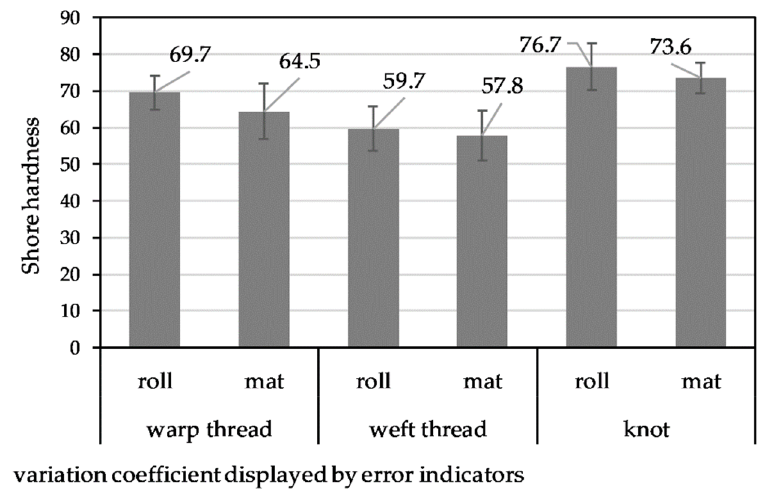
Figure 15. Influence of the textile section on the Shore hardness (mean values of 10 single values).